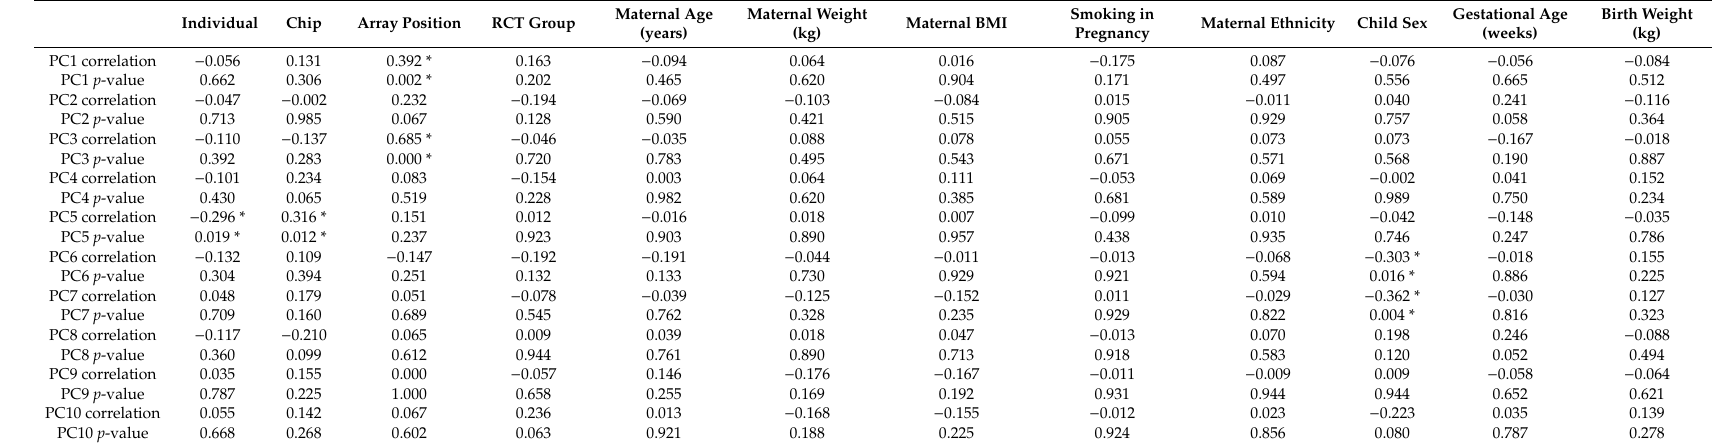
Table 3. Principal component analysis of maternal and child factors during pregnancy and DNA methylation levels in five-year-old o ff spring ( n = 63).